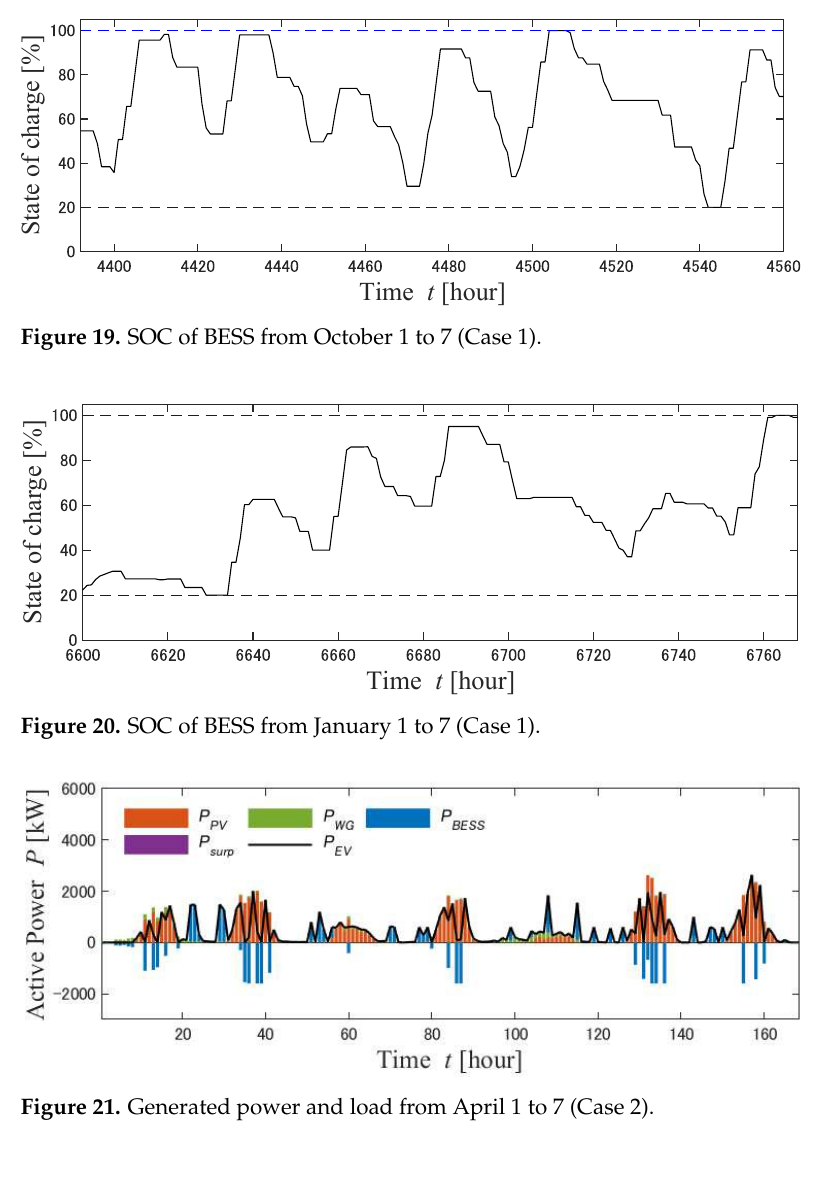
Figure 18. SOC of BESS from July 1 to 7 (Case 1).